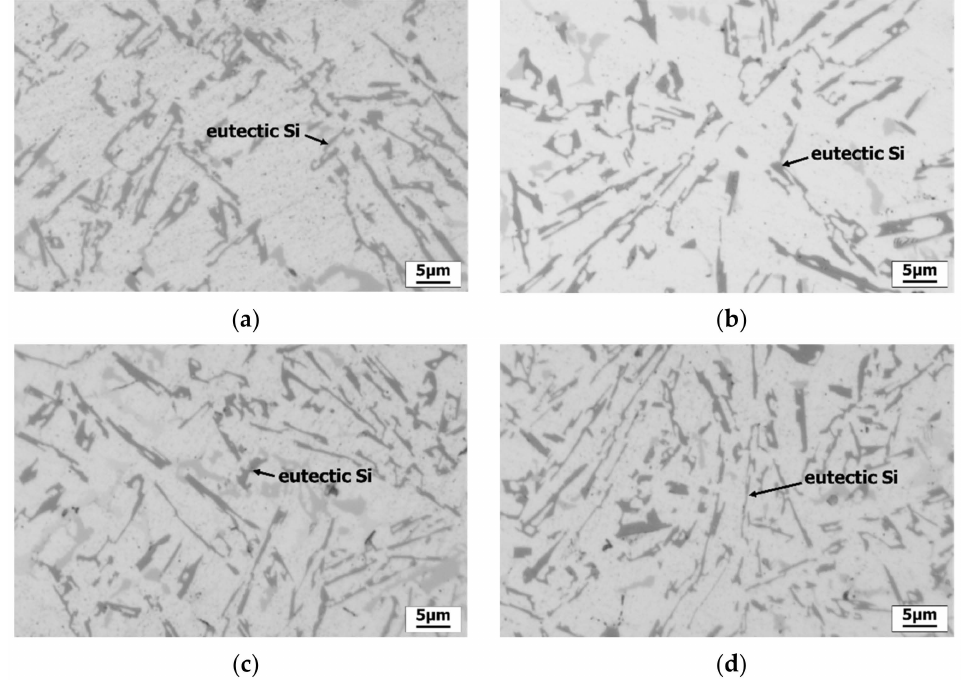
Figure 8. Optical micrographs showing the effect of Bi and P on eutectic phases of ( a )